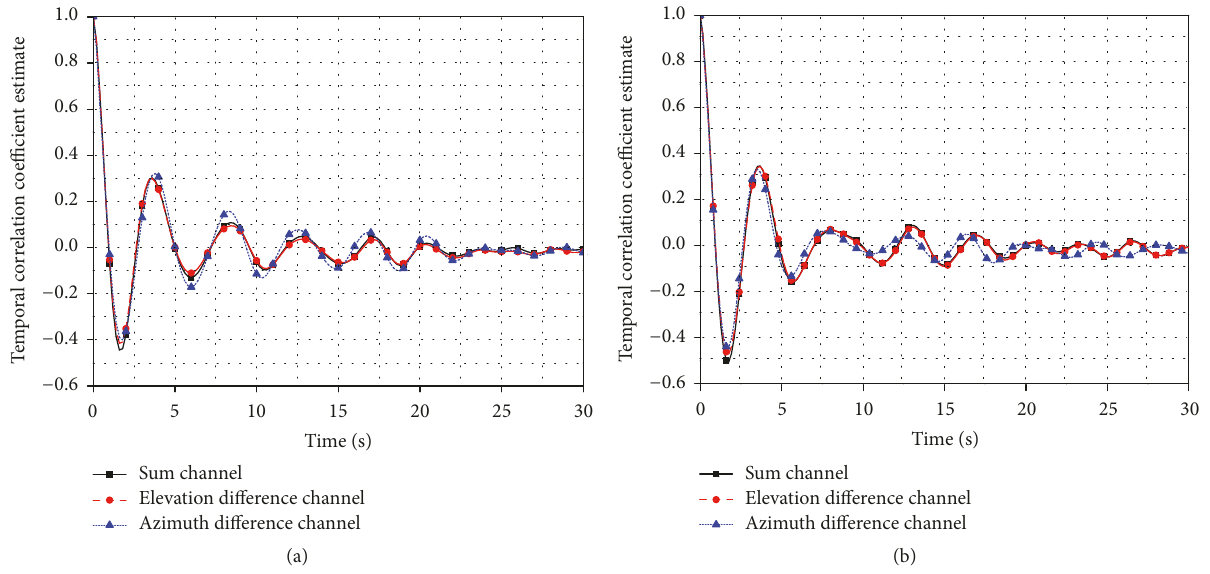
Figure 11: The averages of the temporal correlations of the texture for DS1 and DS2: (a) DS1. (b) DS2.